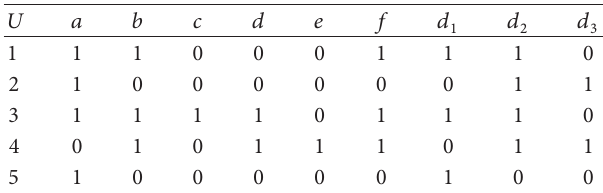
Table 1: A formal decision context Π = (𝐺,𝑀,𝐼,𝑁,𝐽)